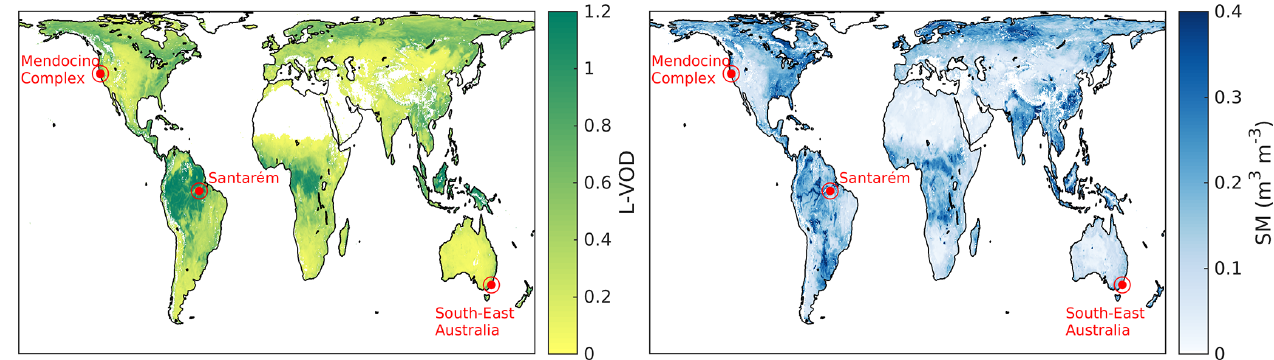
Figure 1. Global maps of SMOS L-VOD (left) and SM (right), with averages for 2011–2020. The red dots show the locations of the three areas of interest: the Mendocino Complex in California, Santarém in Amazonia, and the South Coast of New South Wales in Australia.